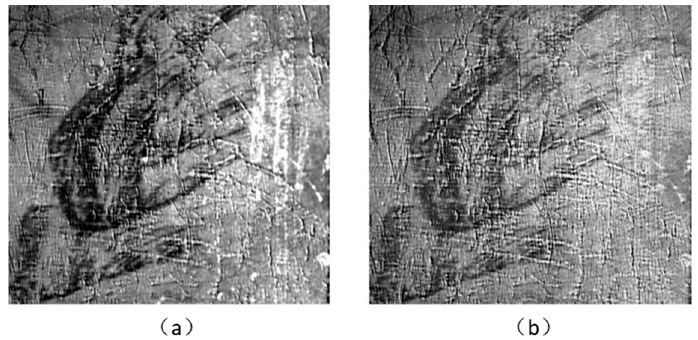
Figure 10. The enhancement results of area 1. ( a ) Subtraction of images transformed by MNF (in the spectral bands of 715–600 nm); ( b ) subtraction of original hyperspectral images without MNF (in the spectral bands of 715–600 nm).